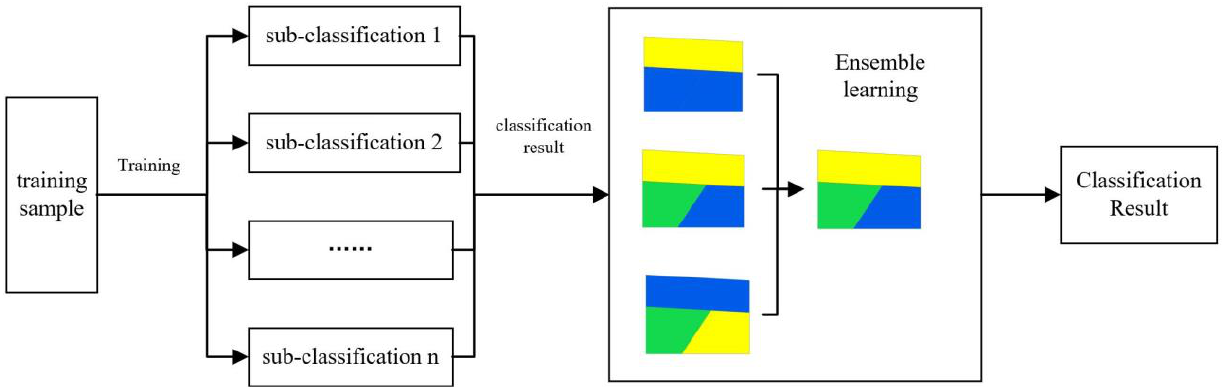
Figure 5. Flow chart of ensemble learning methods.